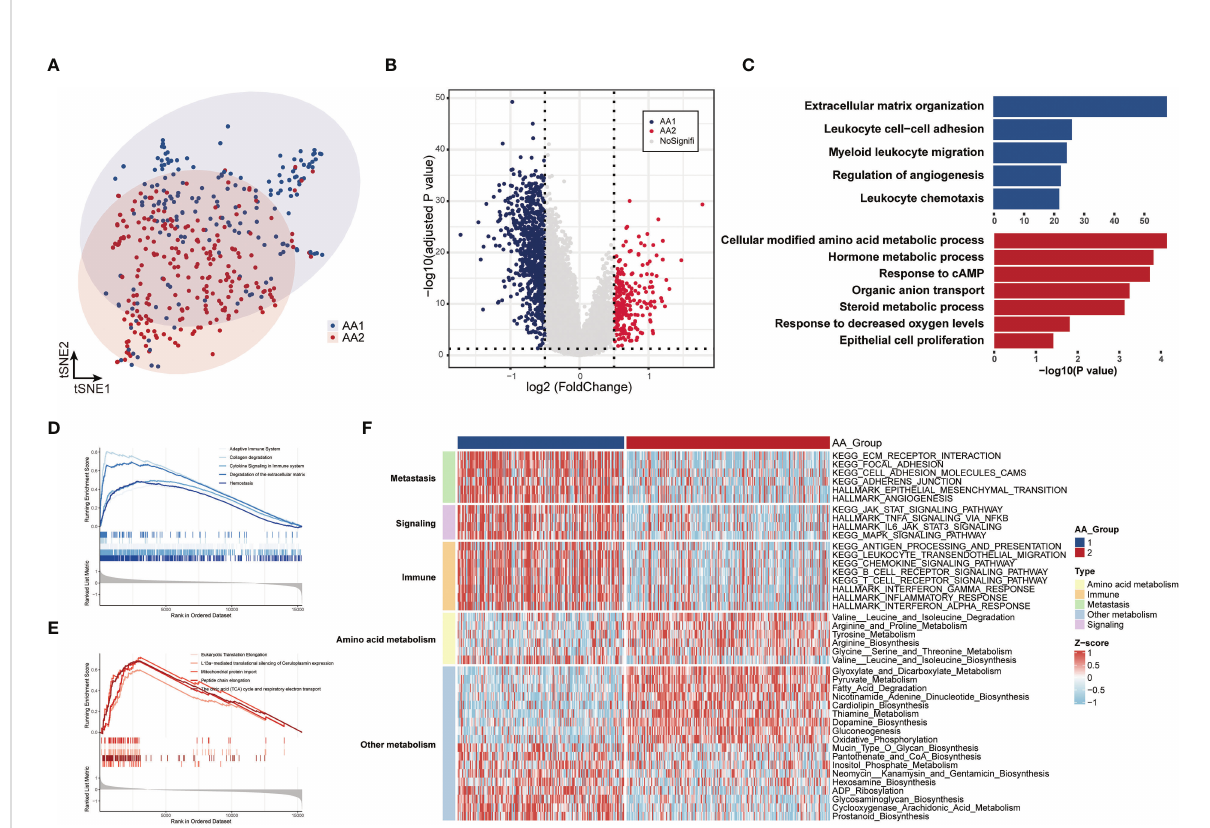
FIGURE 3 Correlation of the AA subtypes with transcriptome differences. (A) T-SNE analysis of transcriptome data from two subtypes. (B) Volcano plot of the differential expressed genes between two subtypes. (C) Gene Ontology Biologic Process of the top differentiated pathways between two subtypes. (D, E) ssGSEA of the enriched pathways in two subtypes. (F) Heatmaps of the signaling, immune, metastasis, and metabolism-related signatures in two